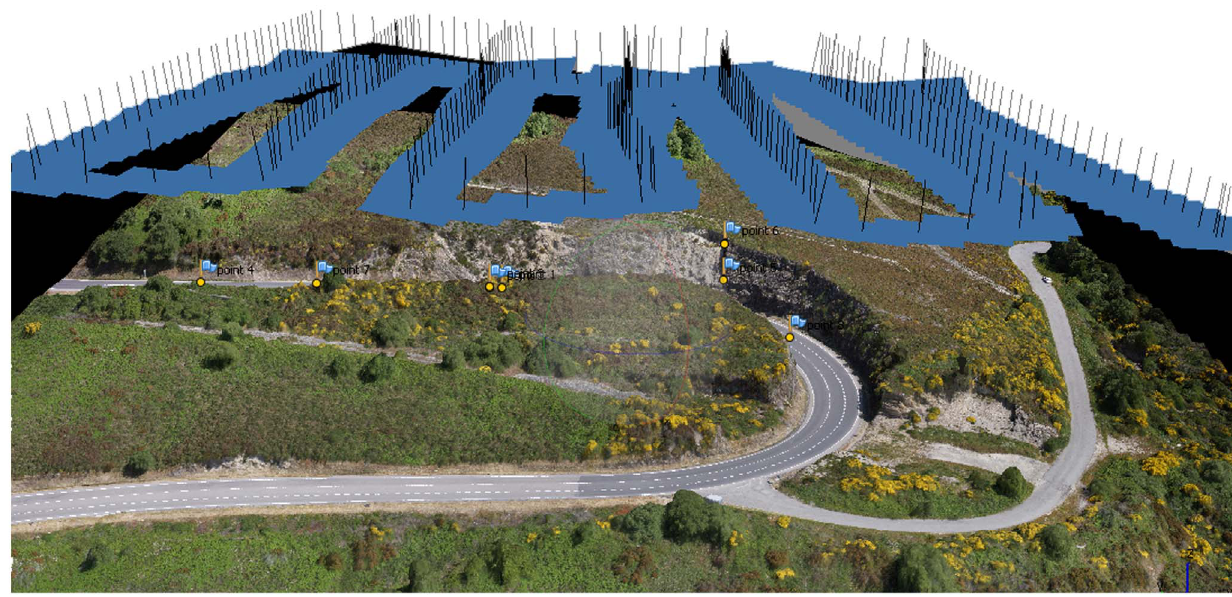
Figure 1. 3D model obtained with Photoscan software from UAV imagery. The camera position during the UAV survey is shown using blue planes. The normal vector of the plane is presented with a black line.